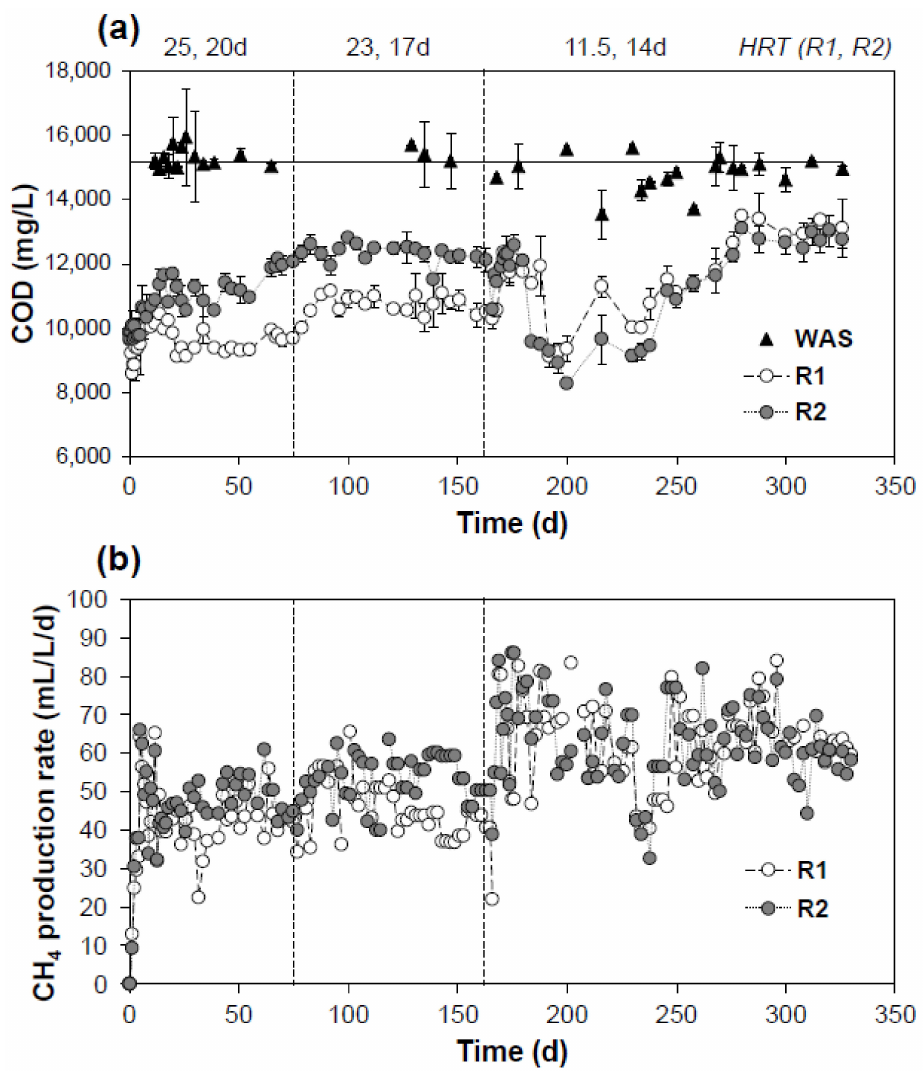
Figure 1. The chemical oxygen demand (COD) ( a ) and CH4 production rate ( b ) profiles of the WAS